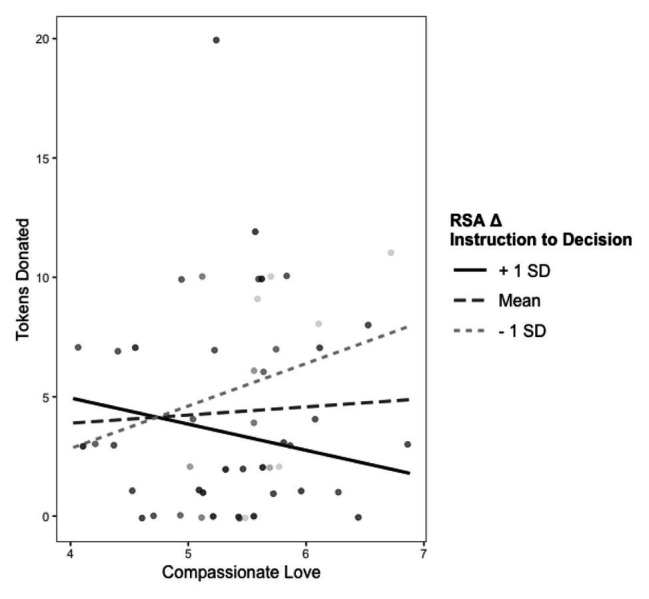
Interaction between maternal compassionate love and RSA change from instruction to decision predicting donation behavior. +1 SD on RSA Δ Instruction to Decision represents increases in RSA from the instruction to decision phase. −1 SD on RSA Δ Instruction to Decision represents stronger decreases in RSA from the instruction to decision phase (i.e., greater RSA suppression).